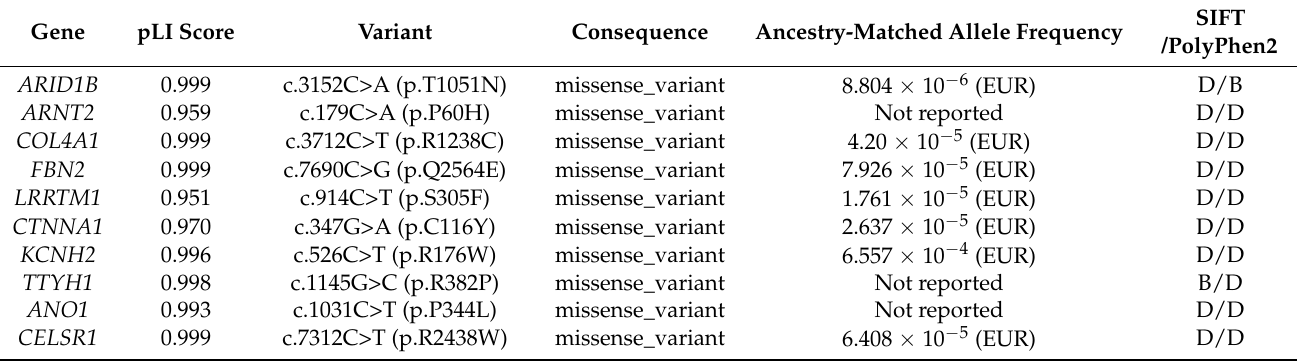
Table 1. List of rare variants in risk